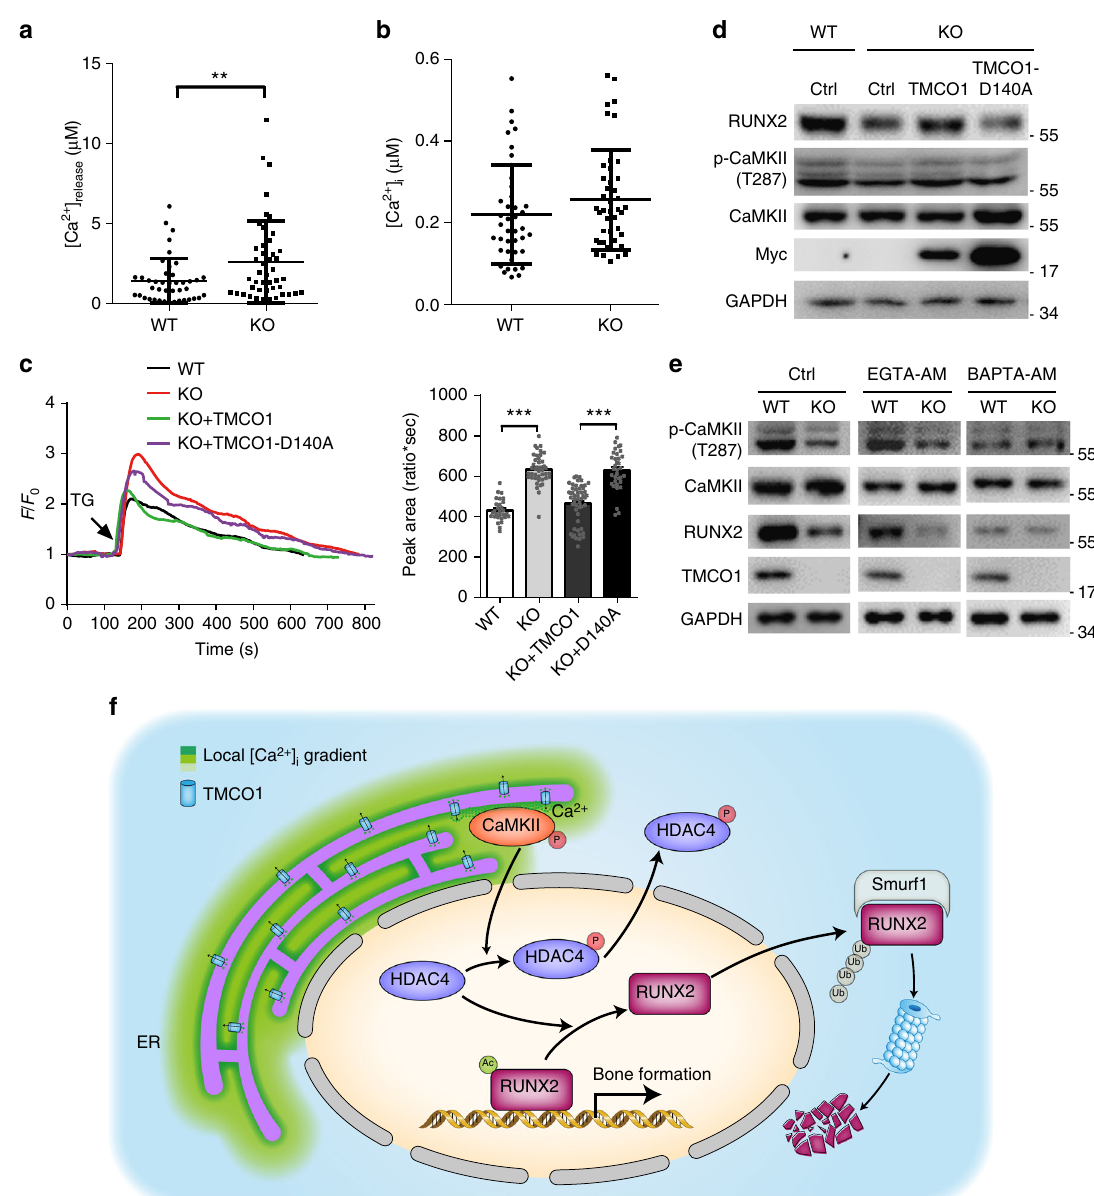
Fig. 6 TMCO1 regulates ER Ca 2 + load and CaMKII activation via local Ca 2 + signaling in osteoblasts. a [Ca 2 + ] release in primary osteoblasts from WT and Tmco1 − / − mice, n = 42 (WT) and n = 45 (KO) cells pooled from three independent experiments. b Resting [Ca 2 + ] i in primary osteoblasts from WT and Tmco1 − / − mice, n = 41 (WT) and n = 43 (KO) cells pooled from three independent experiments. Data are presented as the mean ± s.e.m. unpaired Student ’ s t test, ** P < 0.01. c TG-induced calcium transients in WT ( n = 29) and Tmco1 − / − ( n = 42) osteoblasts and Tmco1 − / − osteoblasts expressing wild-type ( n = 52) and mutated TMCO1 ( n = 34 cells pooled across three independent experiments). Each group was compared with the WT. Data are presented as the mean ± s.e.m. one-way ANOVA with multiple comparison test, *** P < 0.001. d Western blot analysis of RUNX2 in WT and Tmco1 − / − osteoblasts and Tmco1 − / − osteoblasts expressing wild-type and mutated TMCO1. Representative results of three independent experiments are shown. e Effect of BAPTA-AM and EGTA-AM on CaMKII phosphorylation caused by TMCO1 de fi ciency. CaMKII protein expression and phosphorylation were analyzed by western blotting. Representative results of three independent experiments are shown. f Proposed functional model for the regulation of osteoblast function by